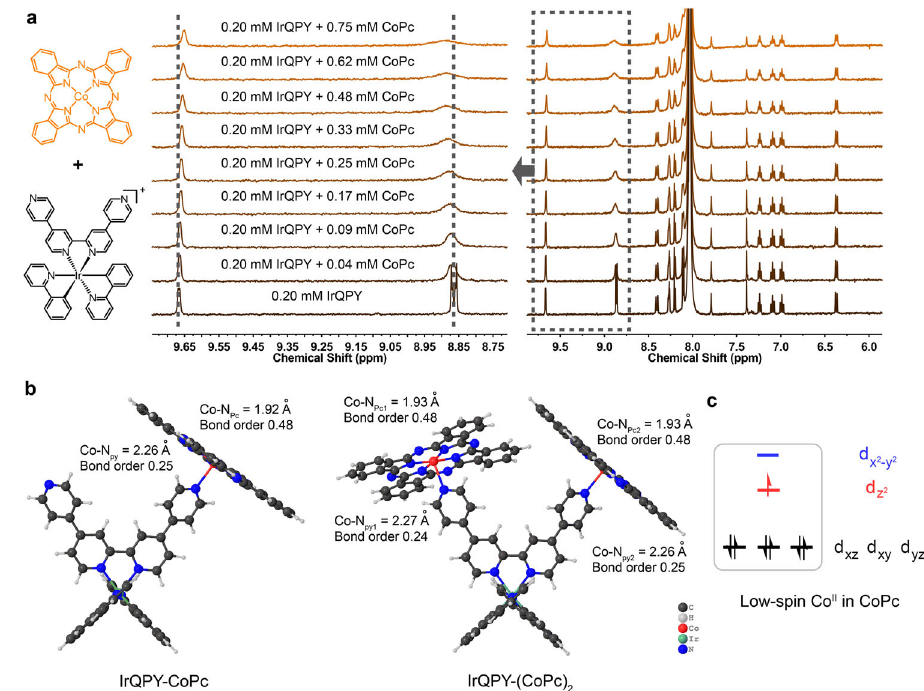
Fig. 2 Characterization of coordinative interaction. a 1 H NMR titration with CoPc into a 0.20 mM DMF-d 7 solution of IrQPY, highlighting some shifted proton signals. b DFT-calculated structures of IrQPY-CoPc and IrQPY-(CoPc) 2 . Counter anions are omitted for clarity. The Co-N bond lengths, bond orders, and c spin states of Co(II) are